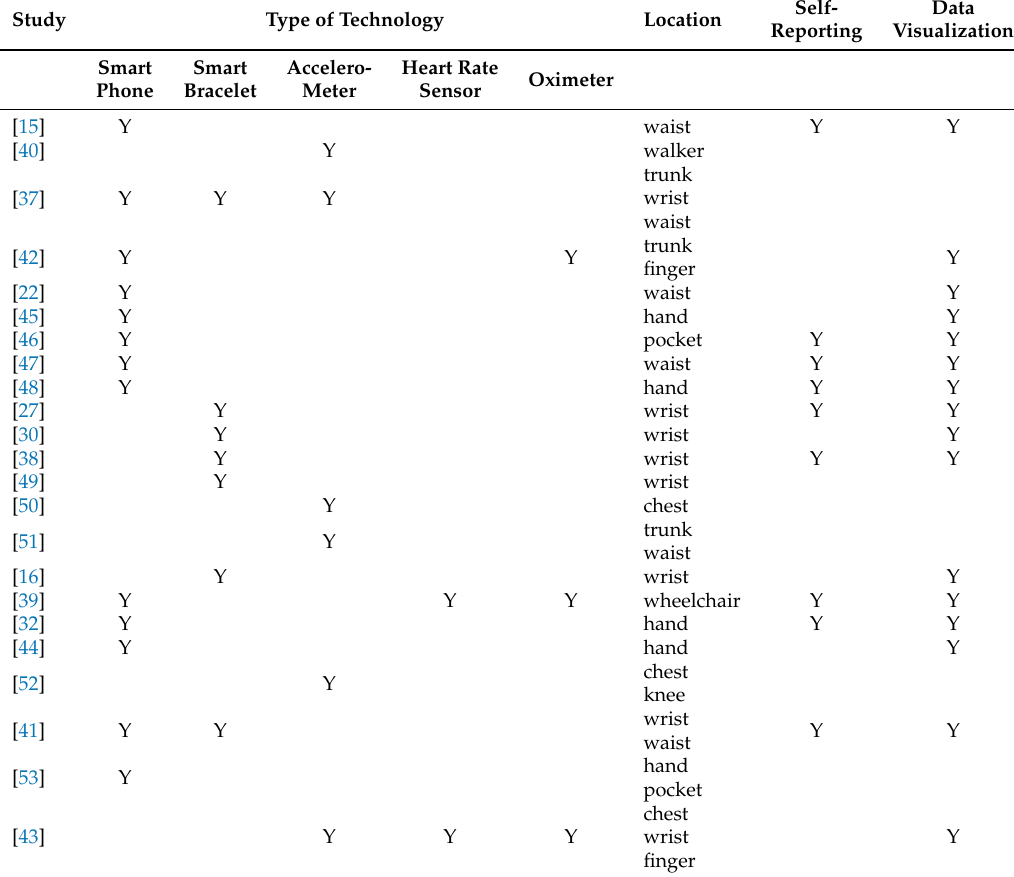
Table 2. Mobile technology used to monitor the health of older adults Y = yes, blank = no.